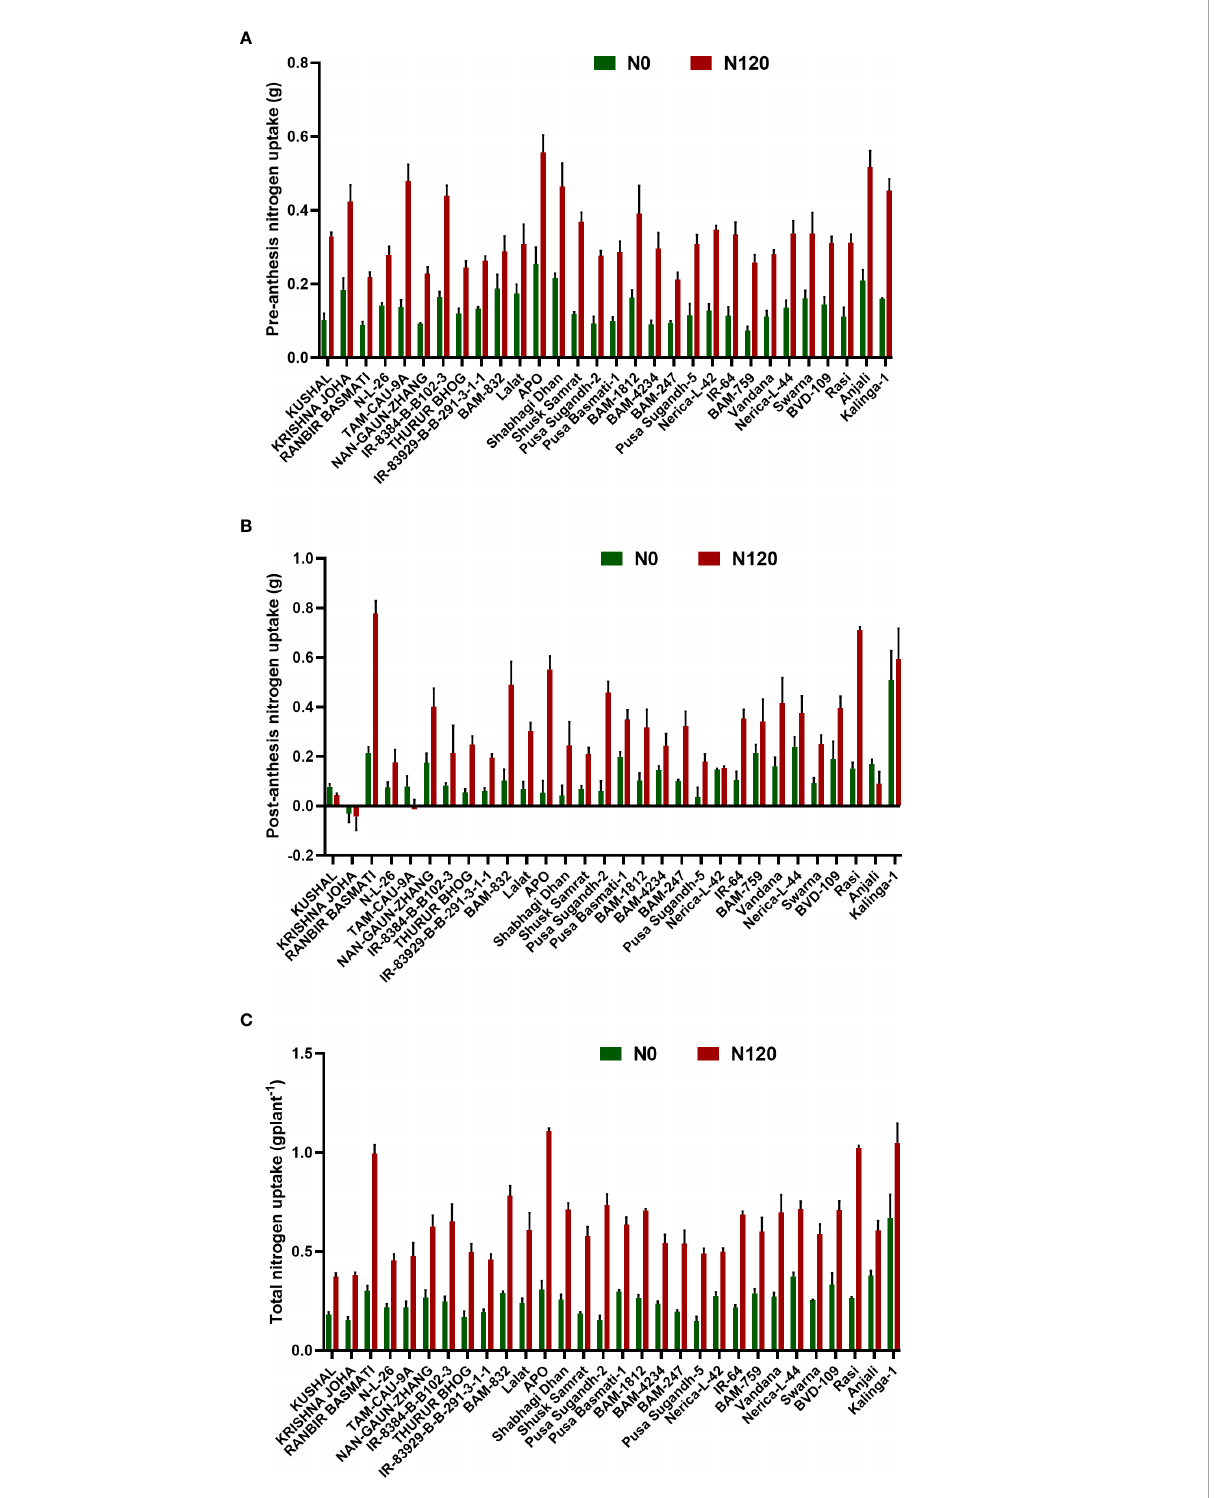
FIGURE 3 Effect of nitrogen de fi cient (0 kg ha-1 fertilizer N: N0) and nitrogen suf fi cient (120 kg ha -1 fertilizer N: N120) fi eld conditions on (A) pre-anthesis nitrogen uptake and (B) post-anthesis nitrogen uptake, and (C) total nitrogen uptake in fi eld- grown diverse rice genotypes during the 2019-kharif season. Values presented are Mean±SE with three